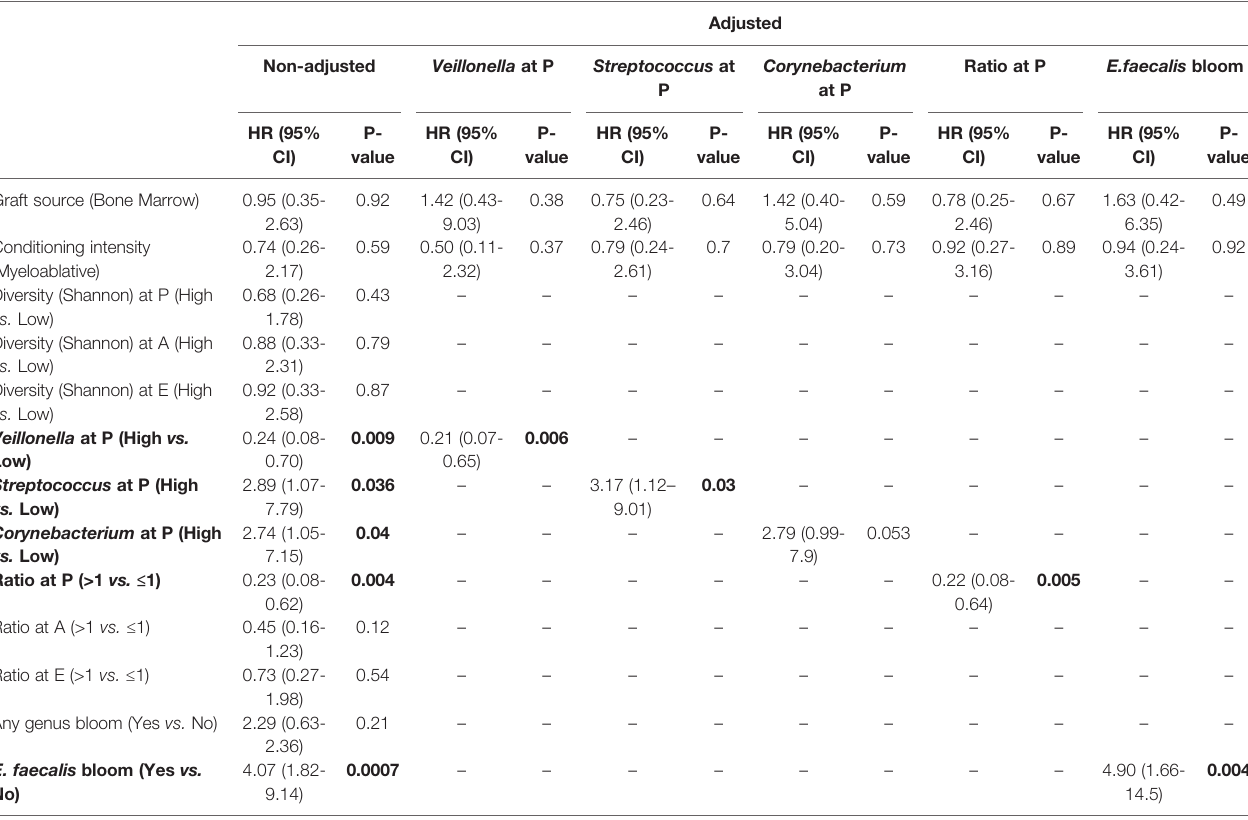
TABLE 2 | Univariate (non-adjusted) and adjusted competing risk analyses for the association of acute graft- versus -host disease with relevant microbiota variables.